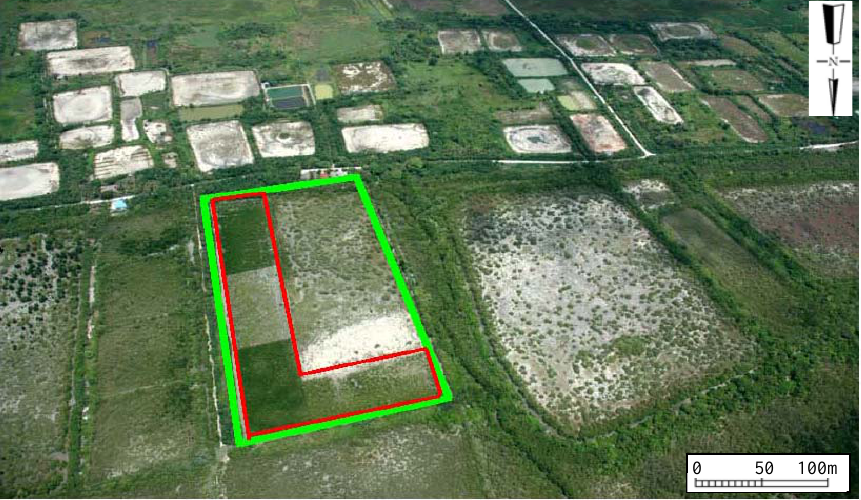
Figure 2. Aerial picture of the study site taken in September 2003. The area marked by the green rectangle shows the study site and that marked by red shows the excavated area. A number of shrimp ponds are located near the study site, some of which are still in operation.